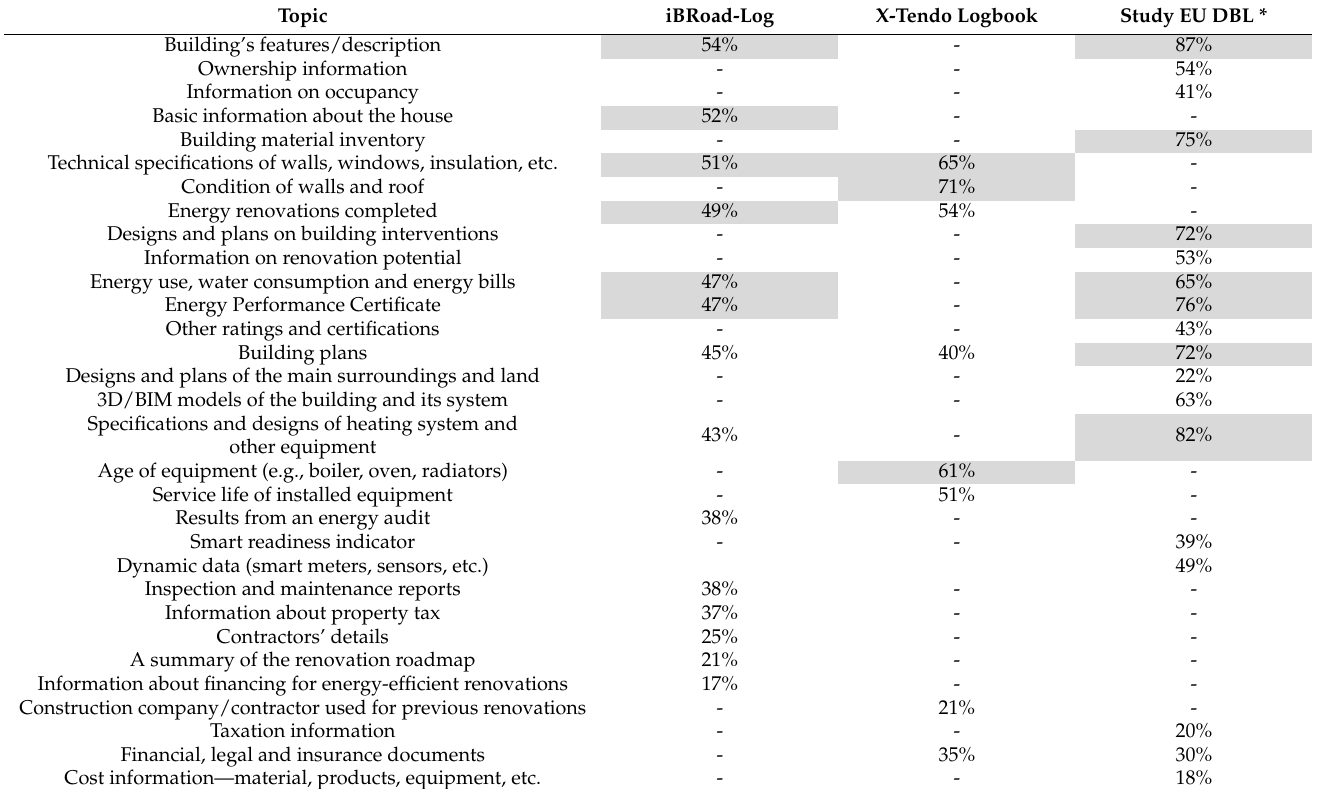
Table 5. Perceived usefulness/importance of the DBL topics according to the surveys. * In the Study on the Development of a European Union Framework for Buildings’ Digital Logbook (Study EU DBL), the exact figure is not provided in the survey, but a bar size. The 40% more important topics of each survey are highlighted